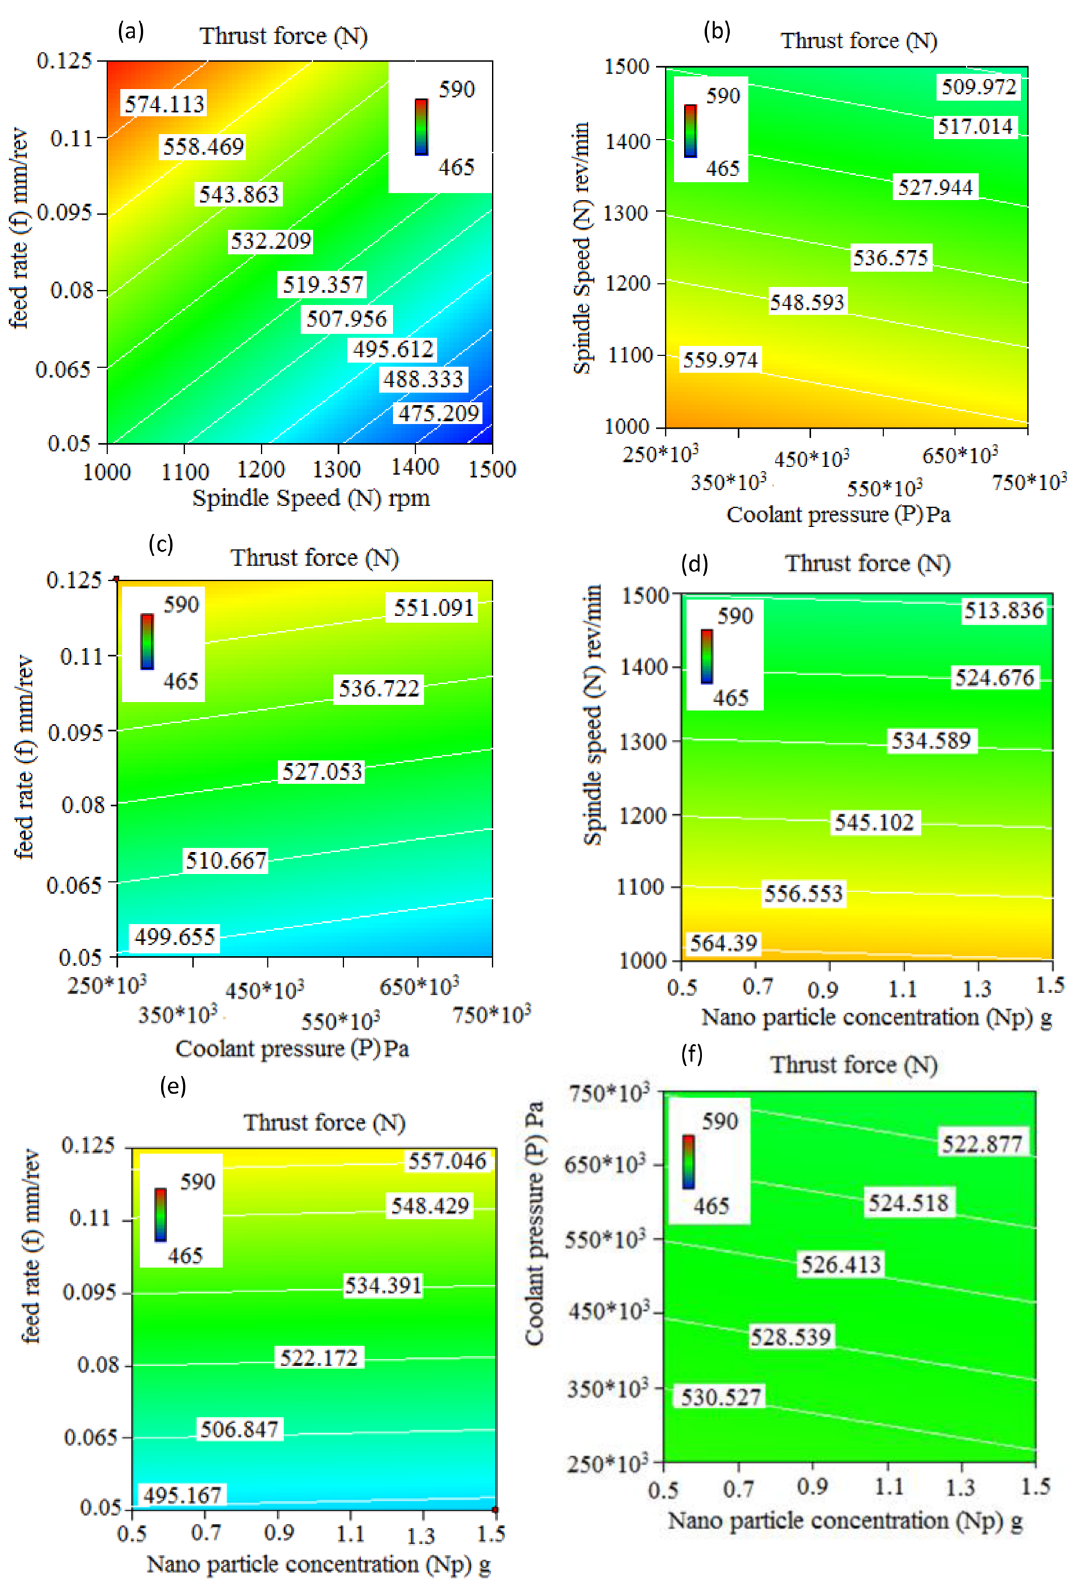
Fig. 4. (a-f) Effects of process parameters on ‘ F z ’ , (a) effect of ‘ N ’ at different ‘ f ’ , (b) Effect of N at different ‘ P ’ , (c) Effect of ‘ f ’ at different ‘ P ’ . (d) Effect of ‘ N ’ at different ‘ N p ’ (e) Feed Effect of ‘ f ’ at different ‘ N p ’ , (f) Effect of ‘ P ’ at different ‘ N p ’